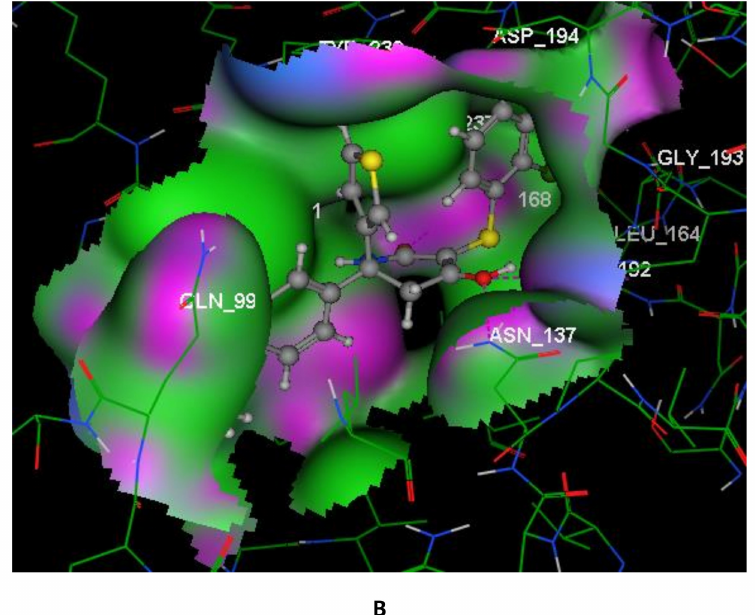
Figure 6. Two-dimensional ( A ) and 3D ( B ) patternsillustrating the proposed binding mode of the co-crystallized ligand GNE-140 in the LDHA binding pocket (PDB code: 4ZVV). Hydrogen bonding interactions with the protein are shown as dashed lines. Green color reflects a hydrophobic area, pink color reflects a high polar area, and blue color reflects a mild polar